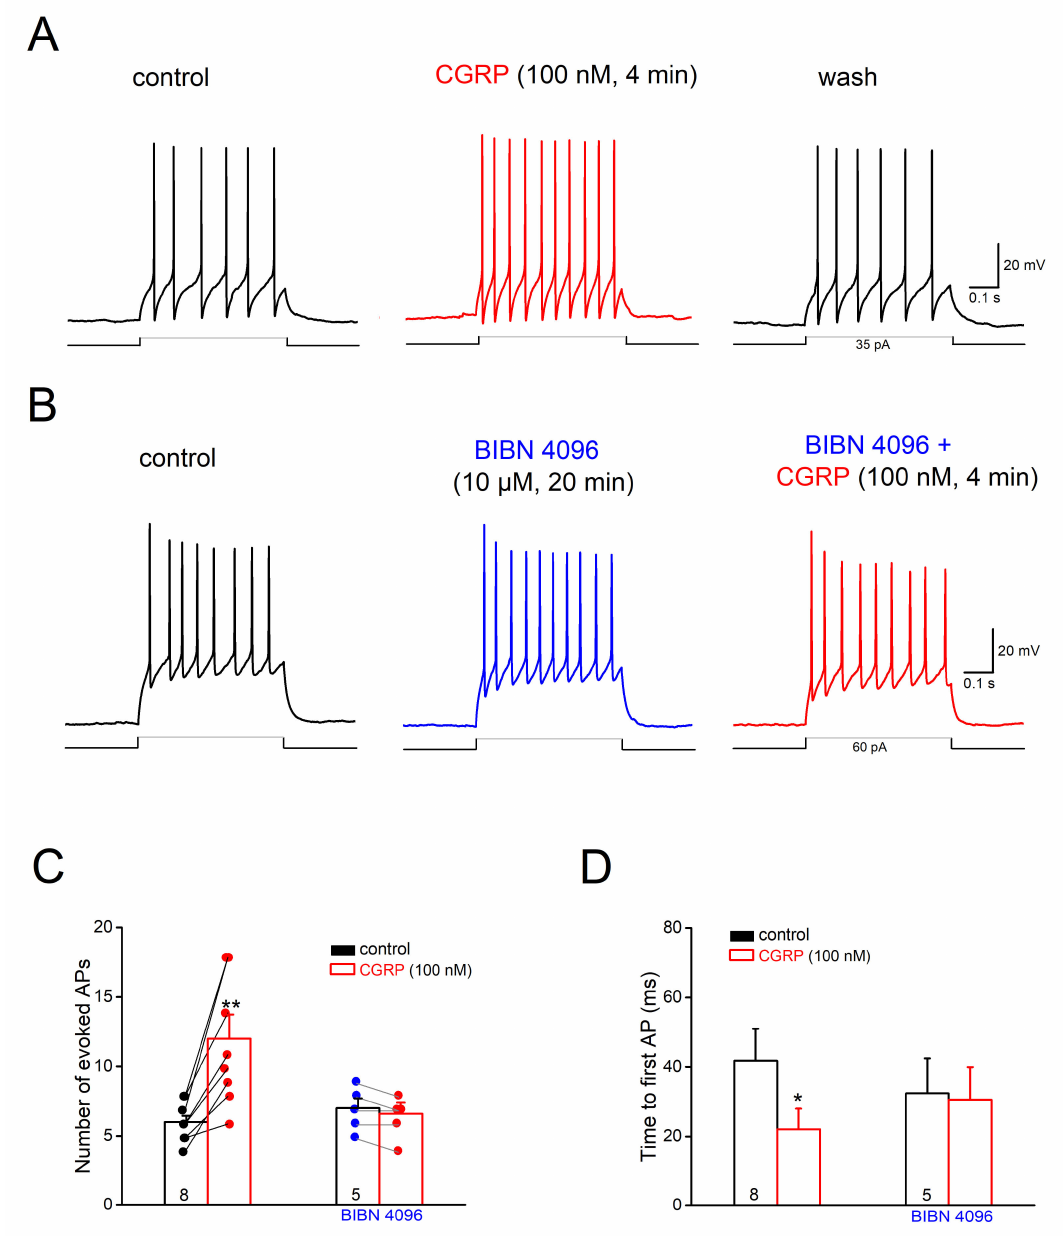
Figure 2. Calcitonin gene-related peptide (CGRP) excites tonic-firing cells in Sp5C laminae I/II. Depolarizing current (35–100 pA) was adjusted individually to evoke 4–10 APs per pulse (500 ms) in each cell before CGRP application, with membrane potential set at − 70 mV. ( A ) Original traces taken before, during and after CGRP (100 nM for 5 min) illustrate the reversible enhancement of AP firing in a lamina I cell. ( B ) Representative traces from another cell show how the CGRP receptor antagonist BIBN 4096BS (10 µ M) prevents the excitatory effect of CGRP. ( C , D ) Histograms summarize CGRP-induced changes in AP discharges ( C ) and time to first AP ( D ) in the absence and in the presence of BIBN 4096BS. Numbers in columns indicate sample size. * p < 0.05; ** p <